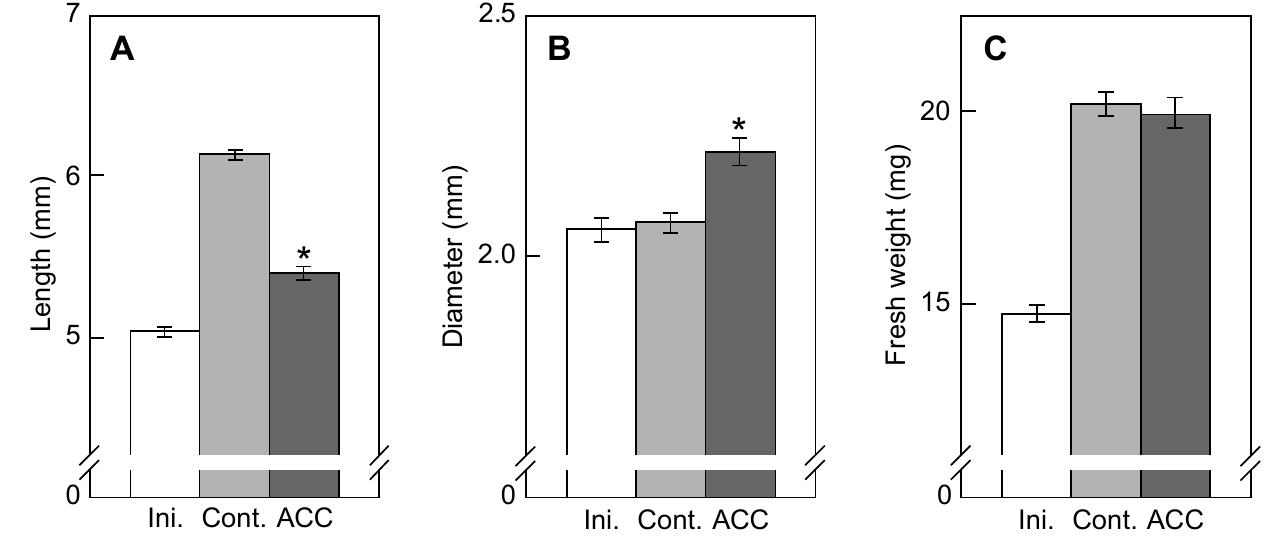
Figure 1. Length, diameter, and fresh weight of ACC-treated azuki bean epicotyls. ACC at 10 − 5 M was applied to seedlings marked with a 5-mm region on epicotyls for 5 h at 25 °C under dark conditions. The length ( A ), diameter ( B ), and fresh weight ( C ) of marked regions are shown. Values are presented as the means ± SE ( n = 30). * p < 0.05, mean with significant differences between control and ACC treatments.